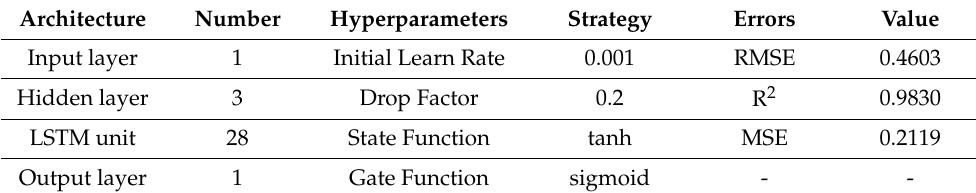
Figure 10. Convergence of the model as the number of iterations is increased. Table 2. Architecture, hyperparameters and errors of the applied